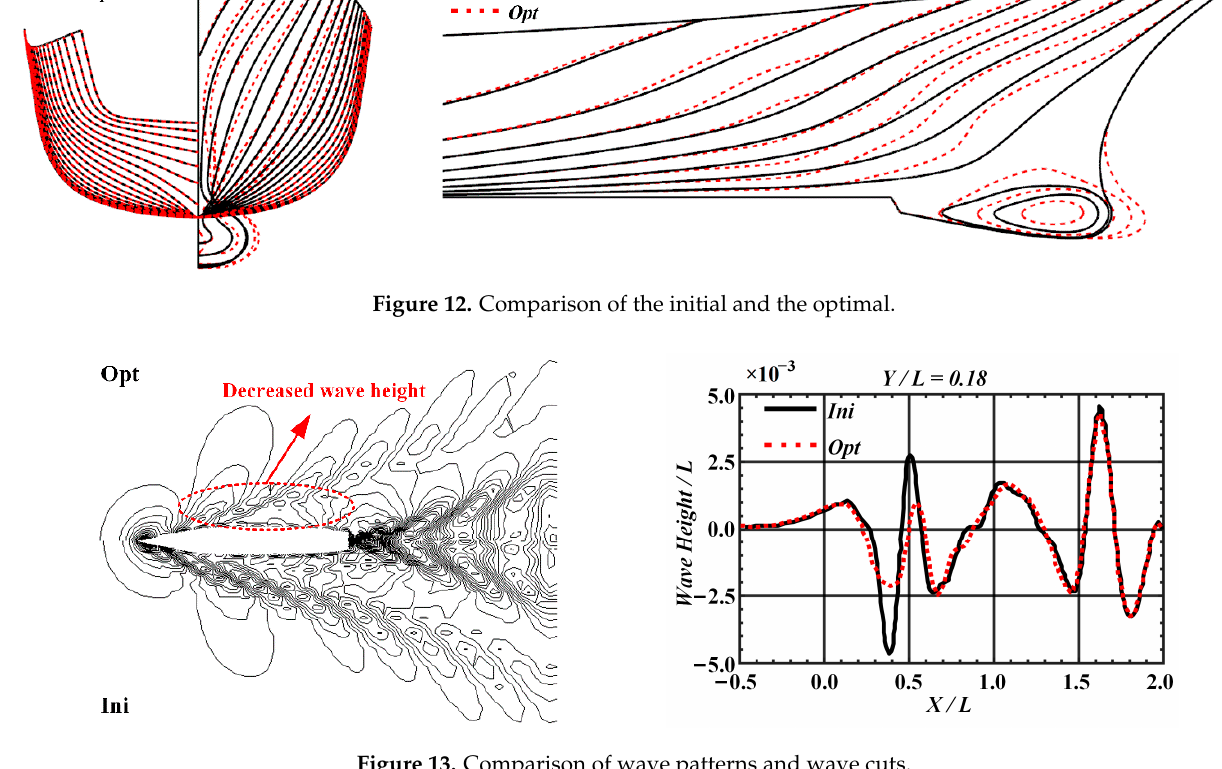
Figure 13. Comparison of wave patterns and wave cuts.